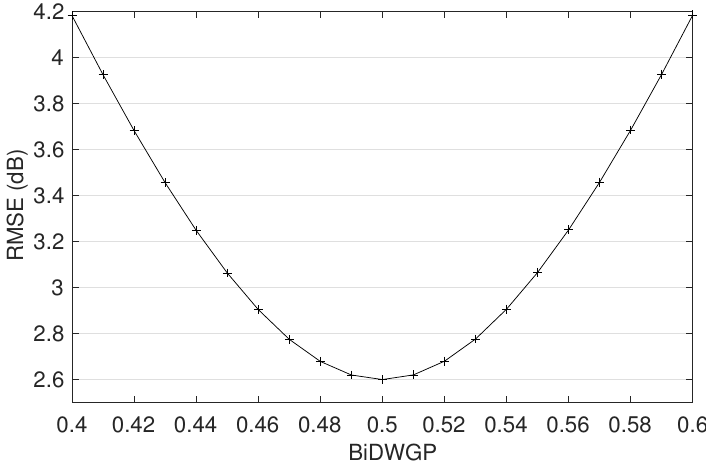
Figure 5. Root-mean-square error (RMSE) between measured and predicted SBR min in decibel as a function of corresponding BiDWGP